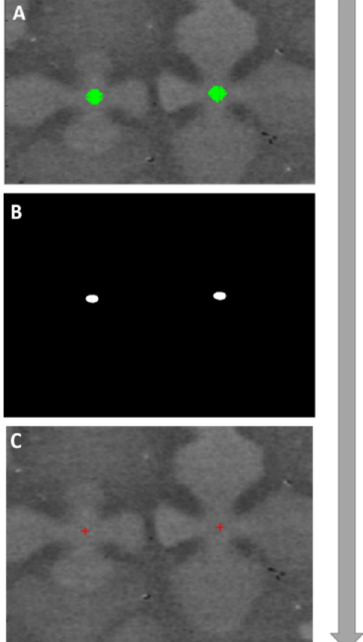
Figure 7. ( A ) scatter of pixel positions of a high correlation region plotted over a segment of the IOI. ( B ) all positions of the correlation peaks mapped into a binary image for the same segment, ( C ) calculated dendrite core positions using a centroid algorithm. Not to scale.